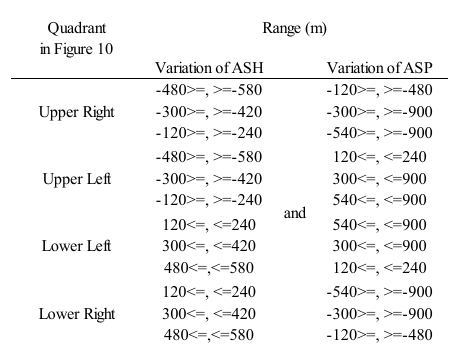
Figure 12 . Spatial variation composed of ASH and ASP between 1995 and 2015 and an aerial photograph in the site B of Figure 11. (c) Dotted lines show the circles with radius ASH (= 630 m in 2015), while the circle of ASH does not appear (ASP 0 ) in 1995. (d) Dotted lines show the circles with radius ASP (= 150 m in 1995, 270 m in 2015).